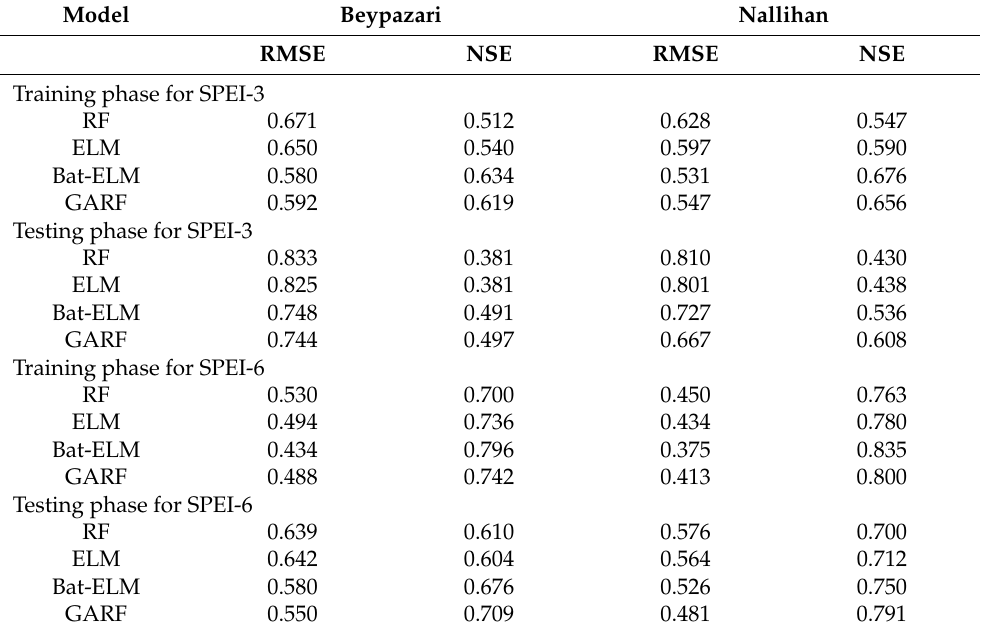
Table 1. Comparison of the ML models’ performance for SPEI-3 and SPEI-6 forecasting. Model RMSE